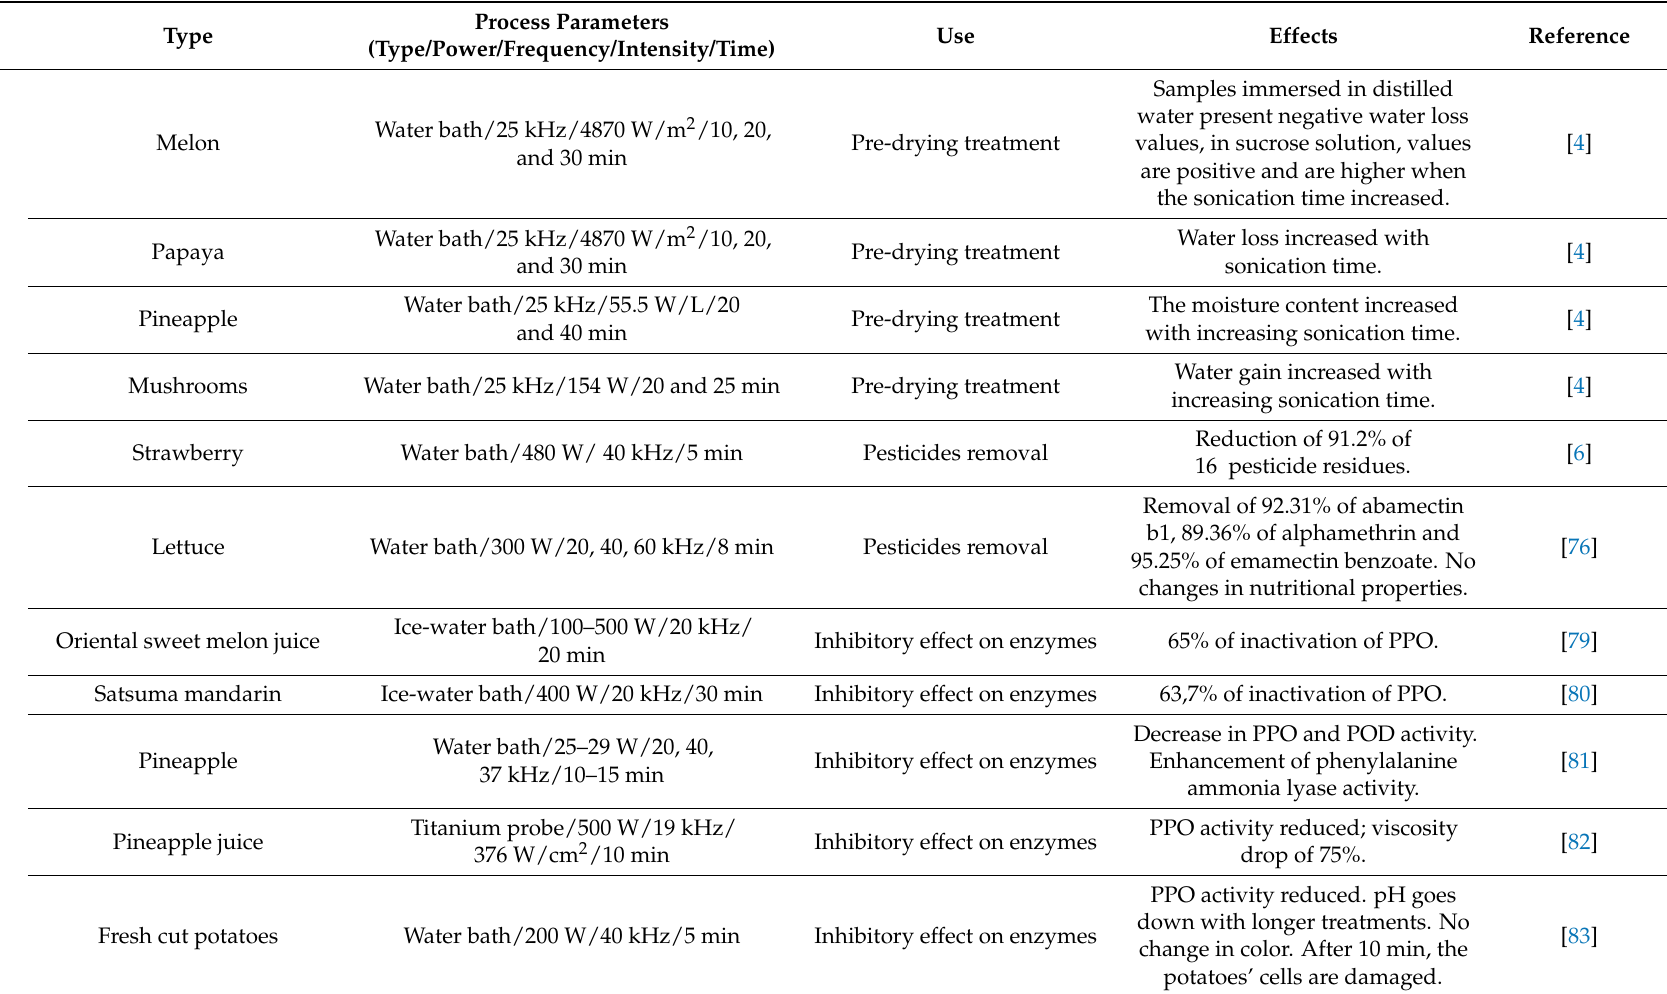
Table 2. Different food types together with ultrasound process parameters and